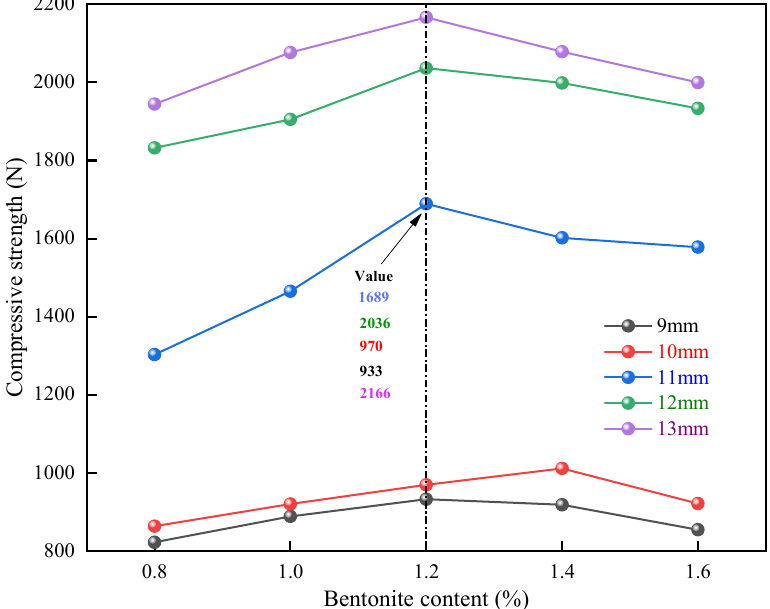
Figure 11. Effect of bentonite content on pellet compressive strength.